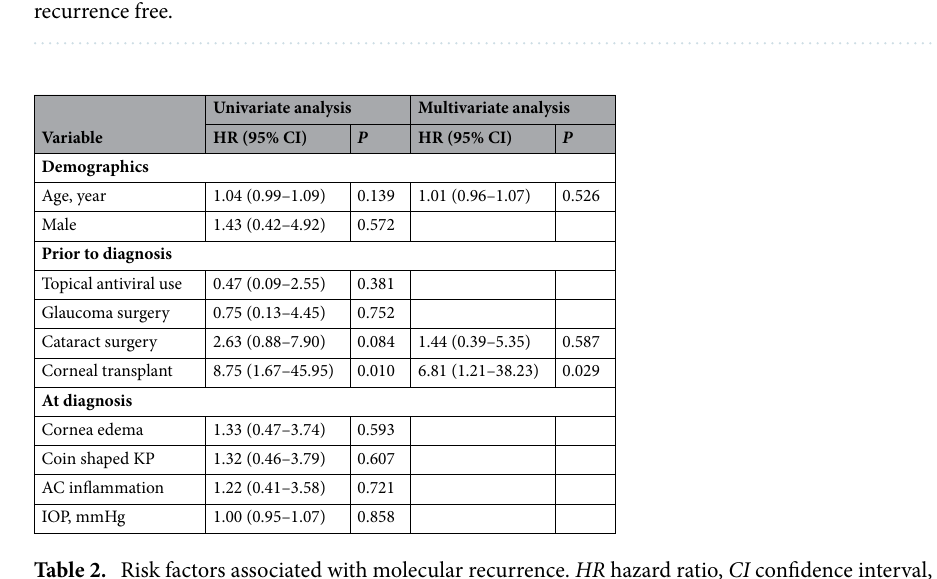
Table 2. Risk factors associated with molecular recurrence. HR hazard ratio, CI confidence interval, KP keratic precipitates, IOP intraocular pressure, AC anterior